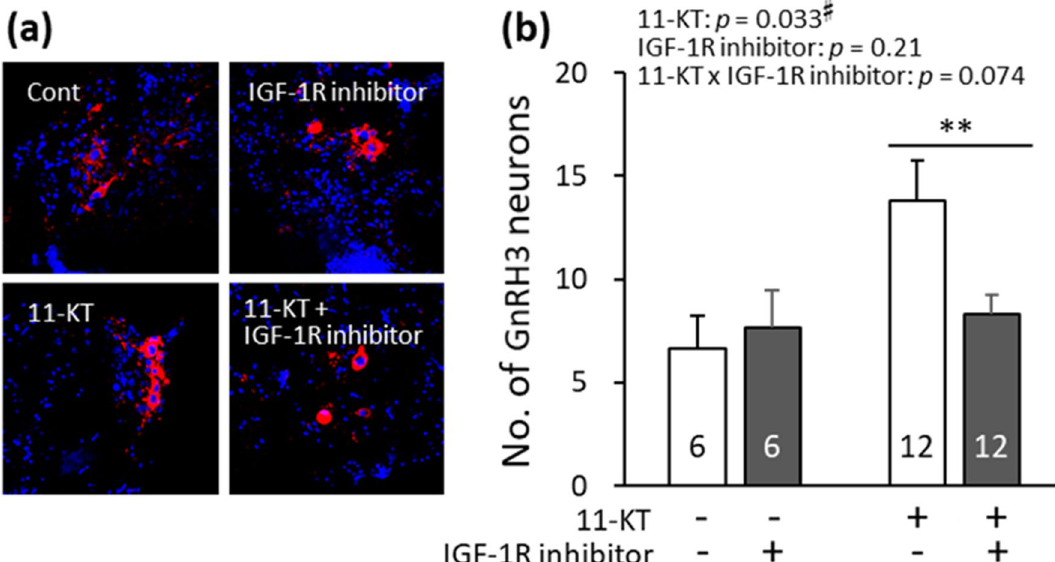
Figure 5. ( a ) Representative images of gonadotropin-releasing hormone 3 (GnRH3) neurons (red) in the following four groups of brain slices: control, insulin-like growth factor 1 receptor (IGF-1R) inhibitor (20 μM BMS-754807)-treated, 11-ketotestosterone (11-KT)-treated (10 nM), and 11-KT- (10 nM) and IGF-1R inhibitor (20 μM BMS-754807)-treated groups. Control and inhibitor-treated slices originated from the same animals, while 11-KT-treated slices and 11-KT- and inhibitor-treated slices originated from the same animals. Cell nuclei (blue) were stained with Hoechst 33342. ( b ) The numbers of GnRH3 neurons counted in the four groups of brain slices. Results from two-way analysis of variance (ANOVA) are shown in the top. Numerals in bars indicate the numbers of animals used for preparing slices. # , a significant difference at p < 0.05 (two-way